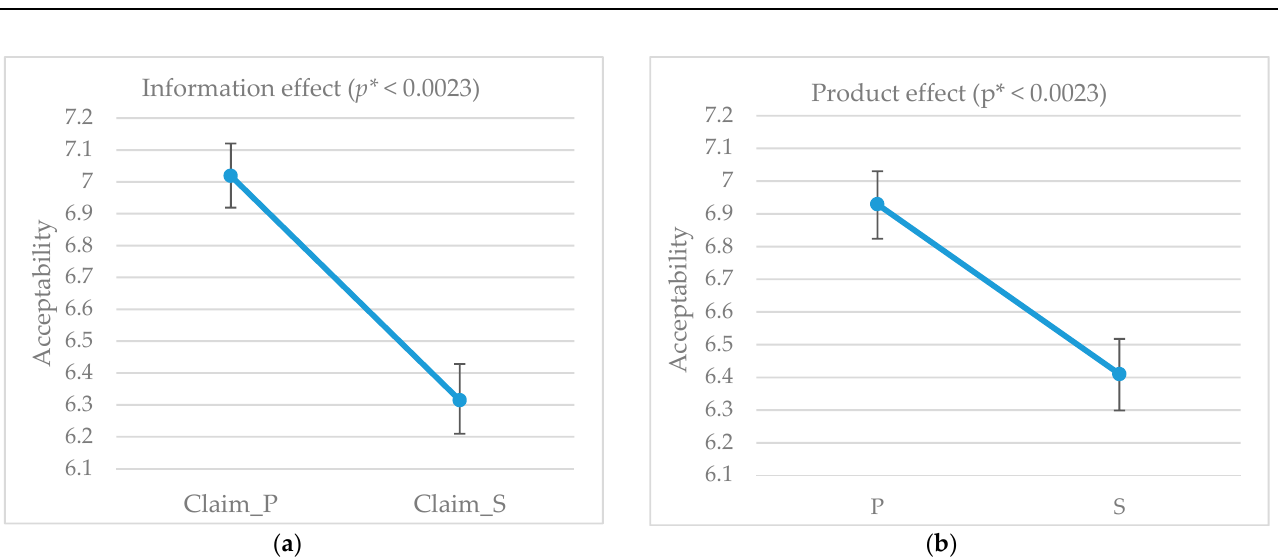
Figure 2. Effects of main factors in the conjoint study for the whole panel: ( a ) Information effect; and ( b ) Product effect. Bonferroni corrected p * is reported.